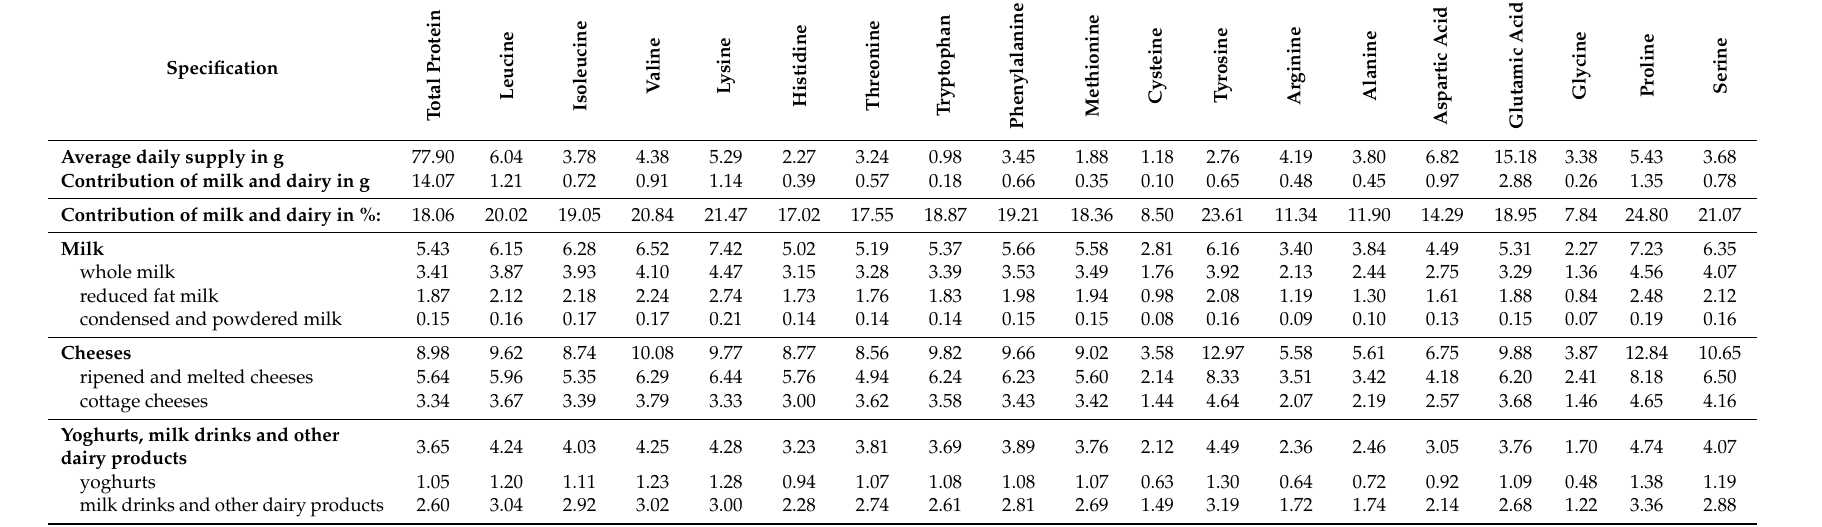
Table 4. Dairy sources of protein and amino acids contribution to the average Polish diet (in g and